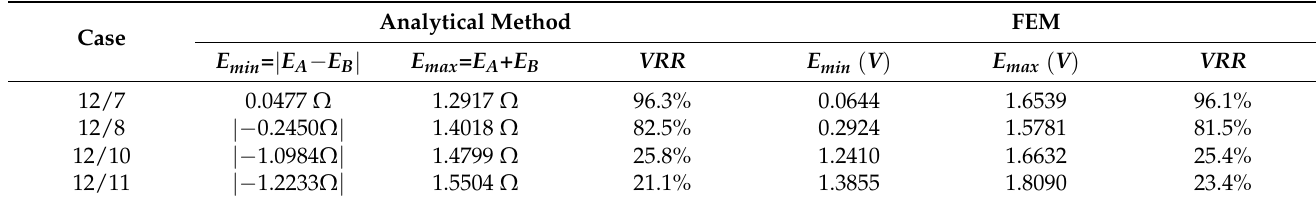
Table 5. Analytical and FEM results of back EMF voltage regulation ratio.